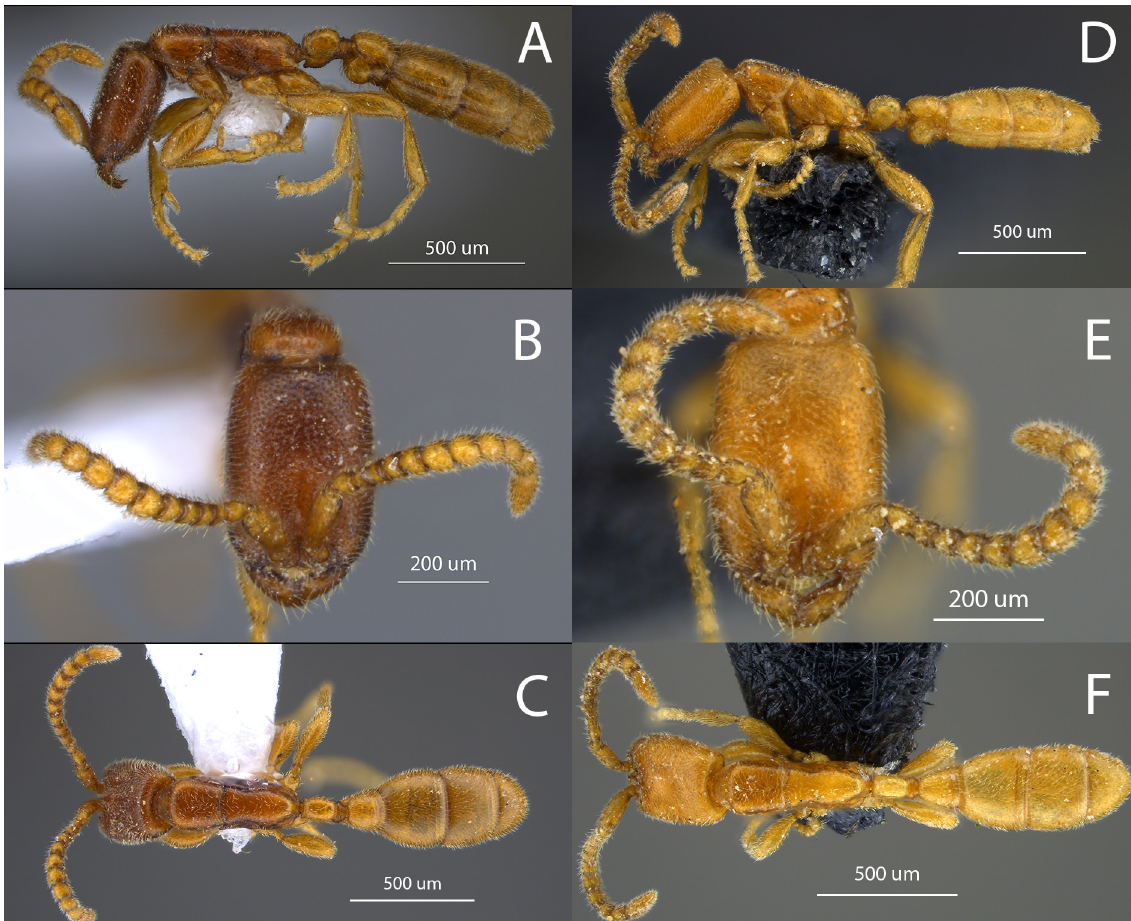
Fig. 2. Leptanilloides copalinga Delsinne & Donoso sp. nov. A–C . Paratype worker (specimen code 4006302). D–F . Holotype worker (specimen code 4006304). A , D . Habitus, dorsal view. B , E . Head in full-face view. C , F . Habitus, lateral